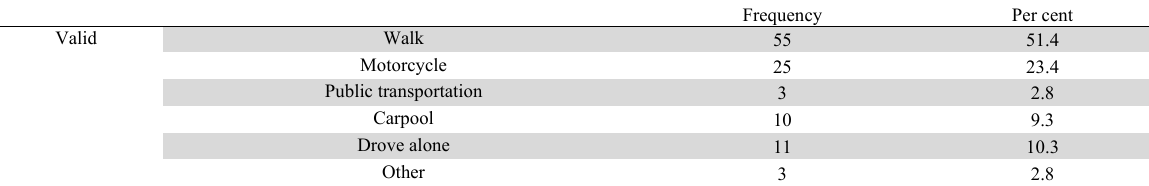
Transportation mode in